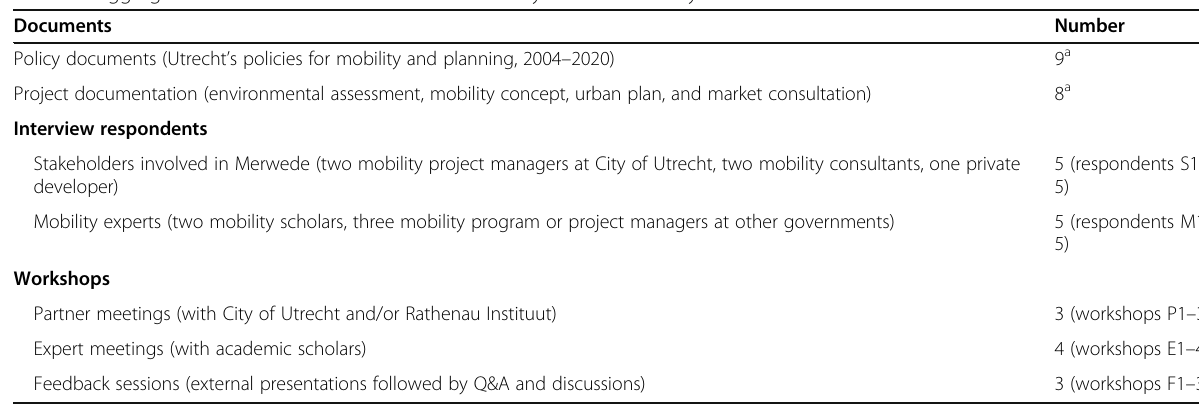
Table 2 Aggregated overview of data collected and analysed for this